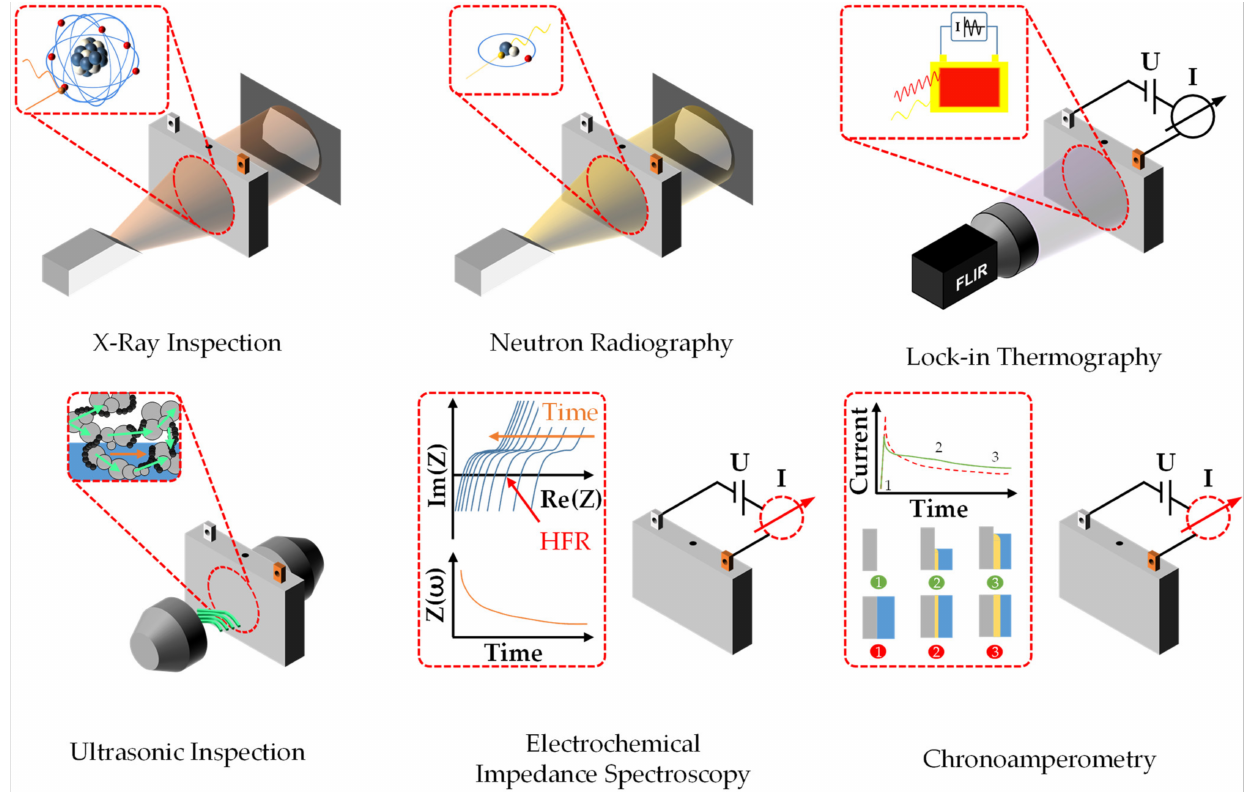
Figure 4. Schematic illustration of the common measurement methods for measuring the wetting properties of assembled battery